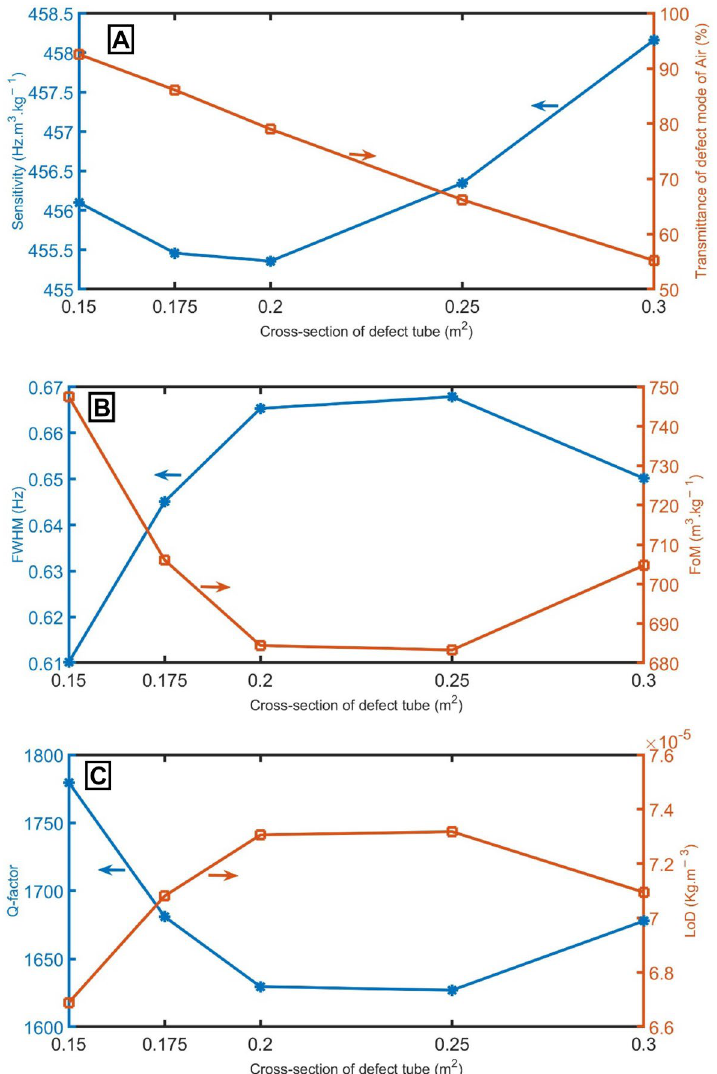
Figure 6. ( A ) sensitivity between air and pure CH 4 samples and transmittance of the resonant mode of air samples, ( B ) FWHM of the resonant mode of air samples and FoM , and ( C ) Q-factor and LoD of the proposed gas sensor at different values of cross-sections of the defect